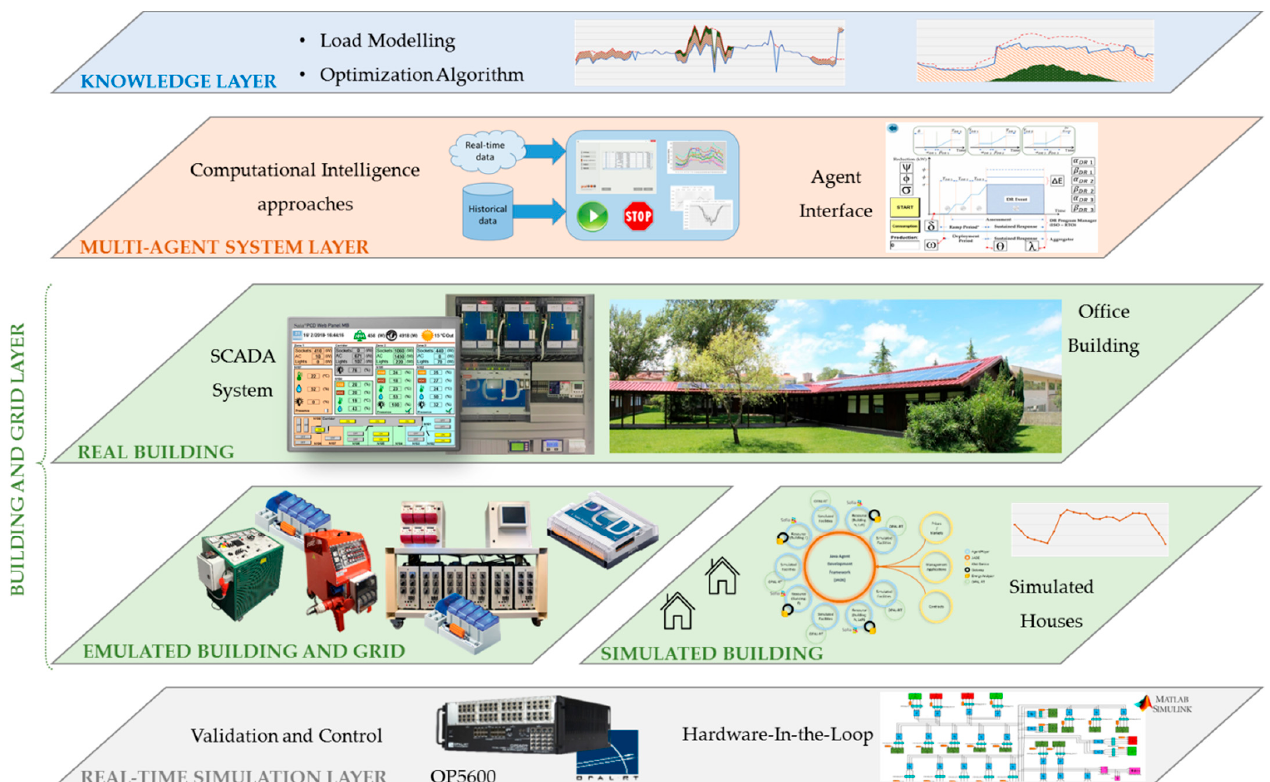
Figure 1. MARTINE (Multi-Agent based Real-Time INfrastruture for Energy) structure and components.